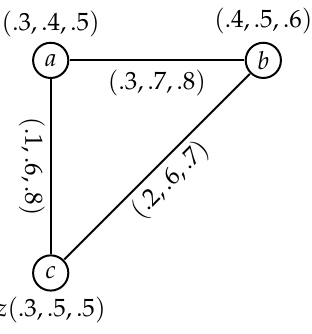
Figure 3. A neutrosophic graph G